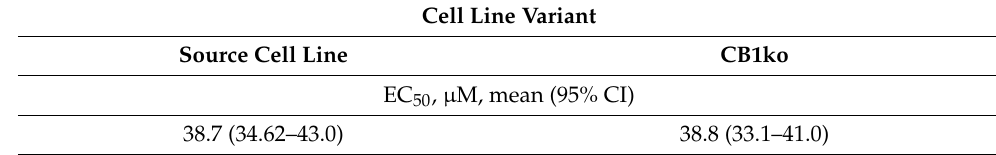
Table 1. The effect of CB1 receptor knockout on DHA-DA cytotoxicity. Incubation 24 h; MTT test.